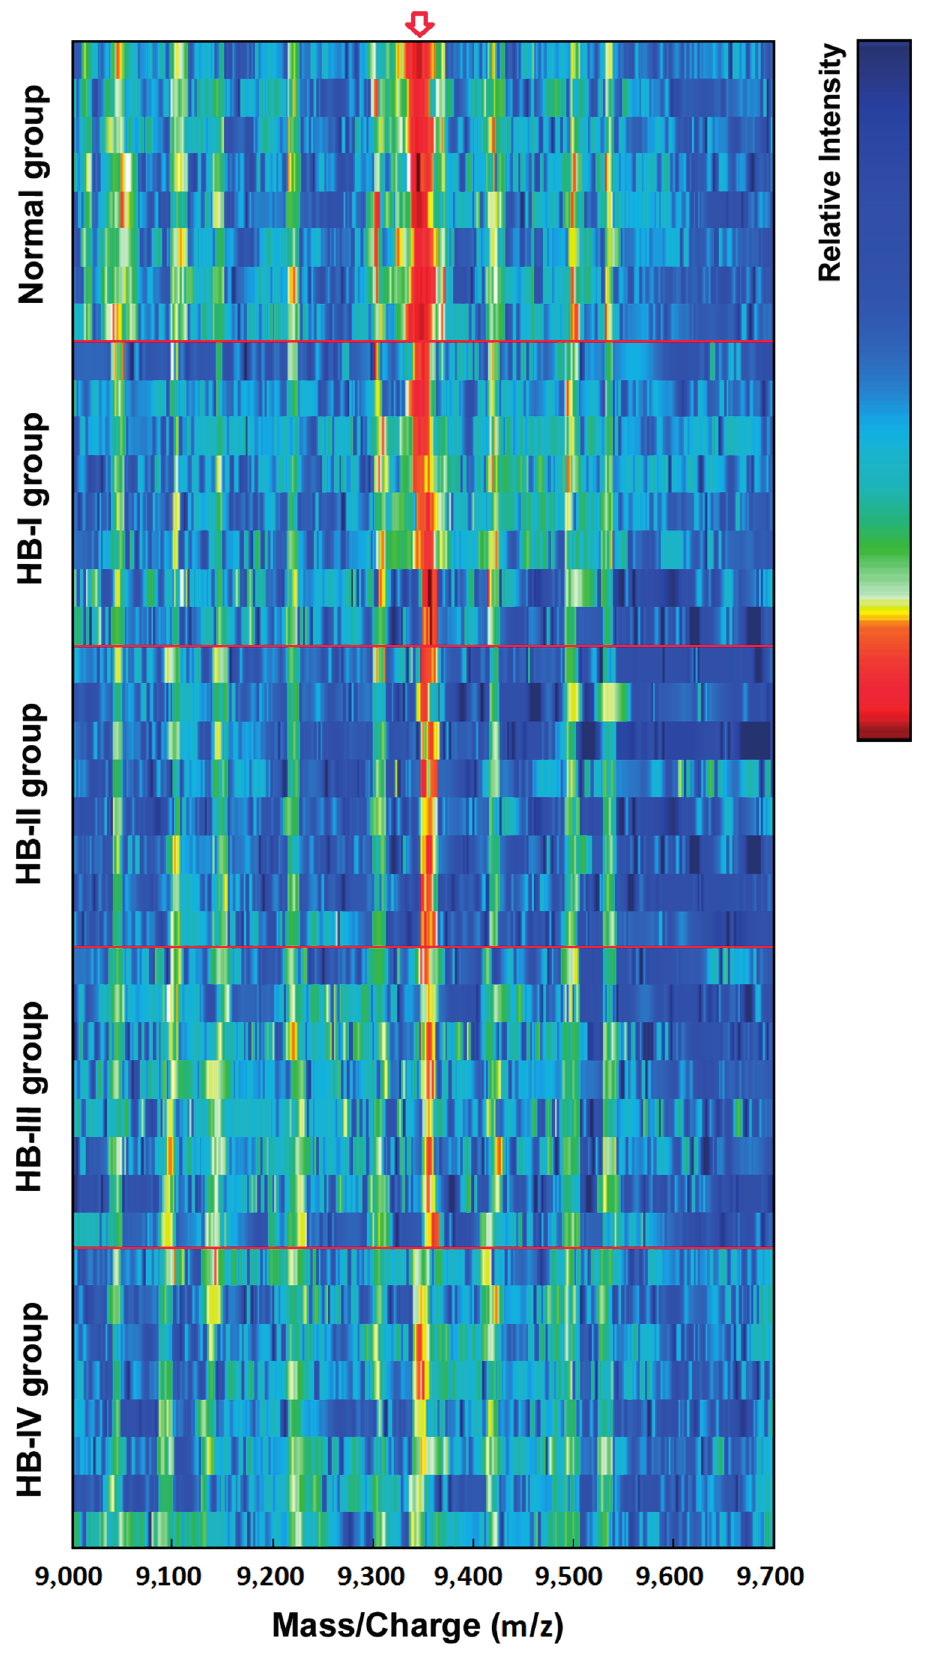
Figure 2. Simulated electrophoretogram of proteins or peptide segments with an m / z of 9348 Da in the normal and HB